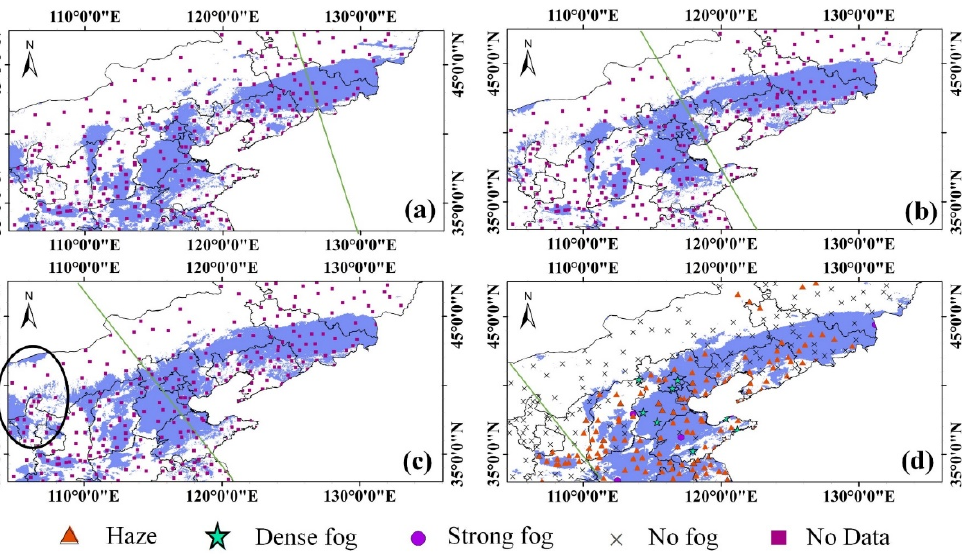
Figure 6. The fog detection results at ( a ) 7:00, ( b ) 7:30, ( c ) 8:00 and ( d ) 8:30 on 18 November 2016. The triangle, star, circle, and cross symbols represent haze, dense fog, strong fog, and non-fog sta- tions, respectively. The square symbol indicates that there is no observation data because of the limit monitoring frequency. The blue area is the fog detected by our algorithm. All the times are at the Beijing Time (8 h later than the Universal Time Coordinated (UTC)) and the green line is the termi- nator line.